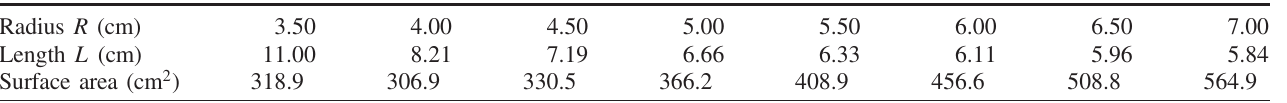
TABLE I. Cavity dimensions and surface areas for TE 111 cavities that resonate at 2.856 GHz. Radius R (cm) Surface area (cm 2